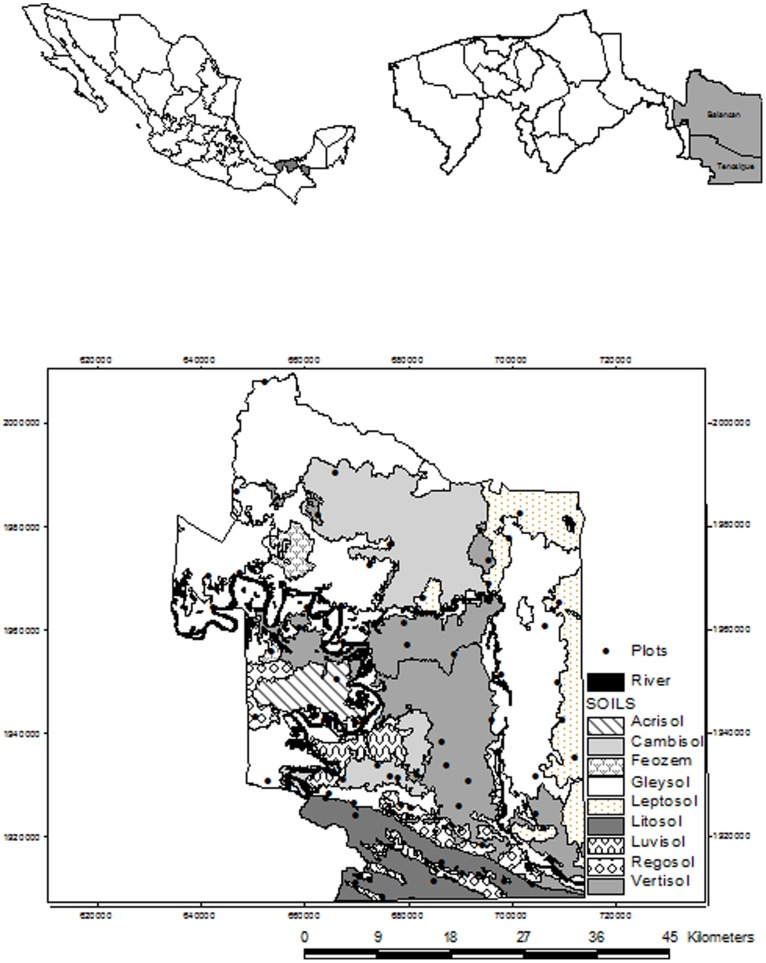
Distribution of 52 evaluated agricultural plots in tropical South-East Mexico.